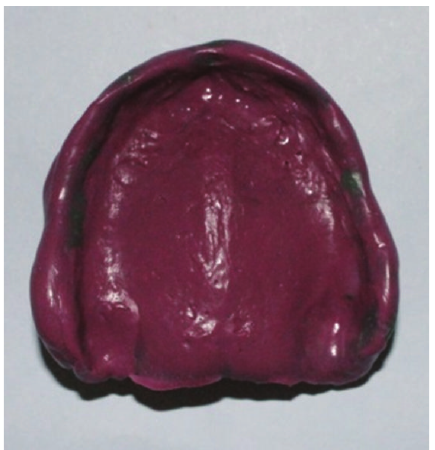
Figure 15: Completed secondary impression with monophase polyvinylsiloxane material.